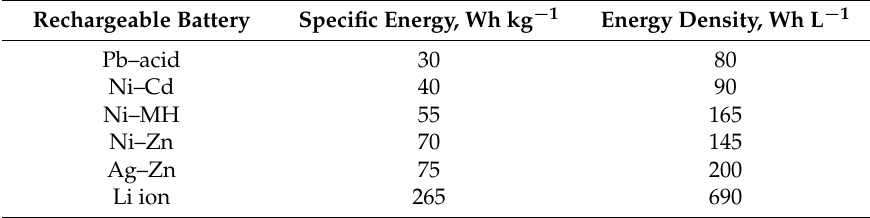
Table 1. Specific energy and energy densities of commercial rechargeable batteries. Reprint with permission [43]; 2017, American Chemical